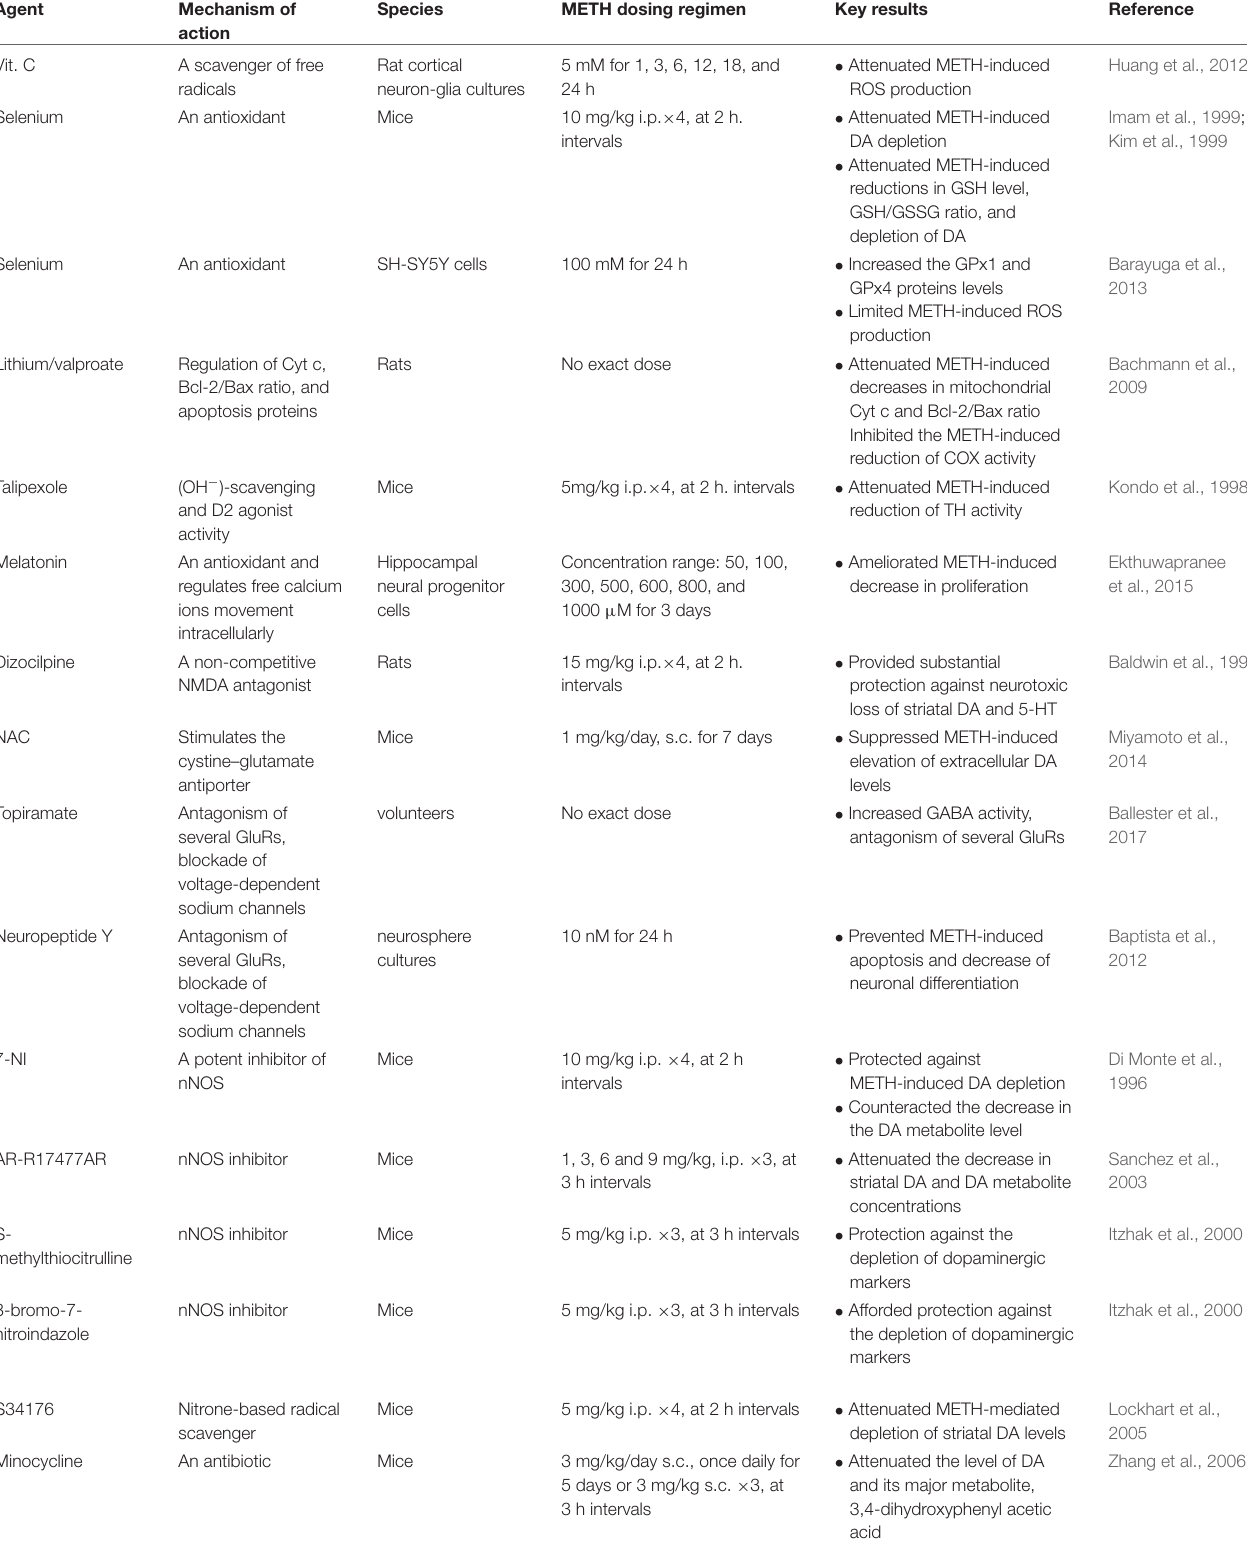
TABLE 2 | The summary of pharmacotherapy approaches in METH-induced neurotoxicity in vivo or in